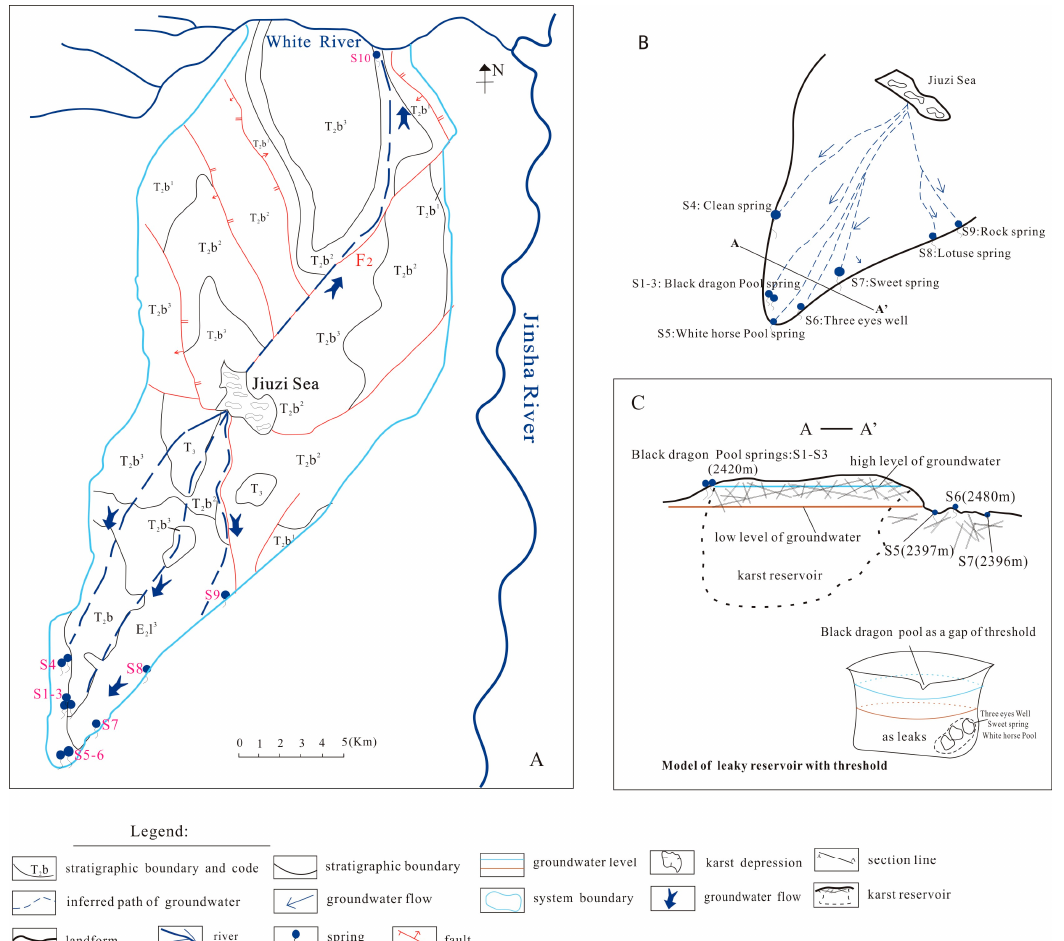
Figure 4. The distribution sketch of inferring karst conduits and conceptual conduit structure of springs in the Black Dragon Pool: ( A ) the proven hydraulic connection by BTCs of our trace test; ( B ) the conduits distribution from the Jiuzi Sea to southern springs, and the profile line of A-A’; and ( C ) the profile of A-A’ and a leaky reservoir with threshold effect which is used to interpret the conceptual conduit structure of springs in Black Dragon Pool and Ancient City.